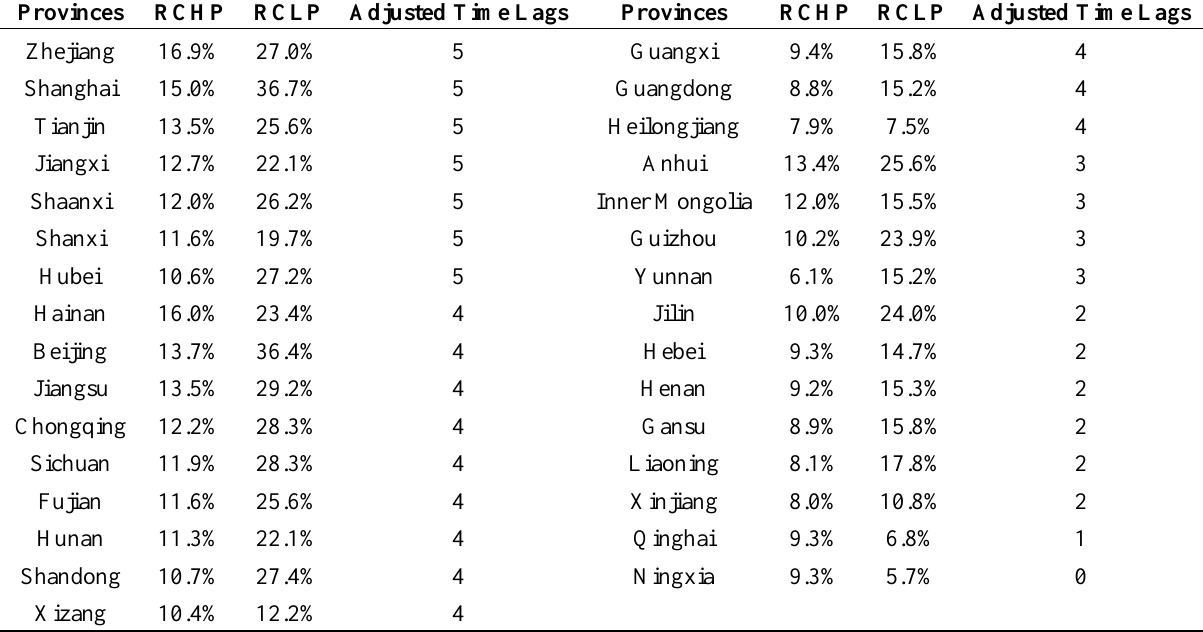
Table 4. The average annual Rate of Change in Housing Price (RCHP), Rate of Change in Land Price (RCLP), and Adjusted land development time lags ( l in China between 2000 and